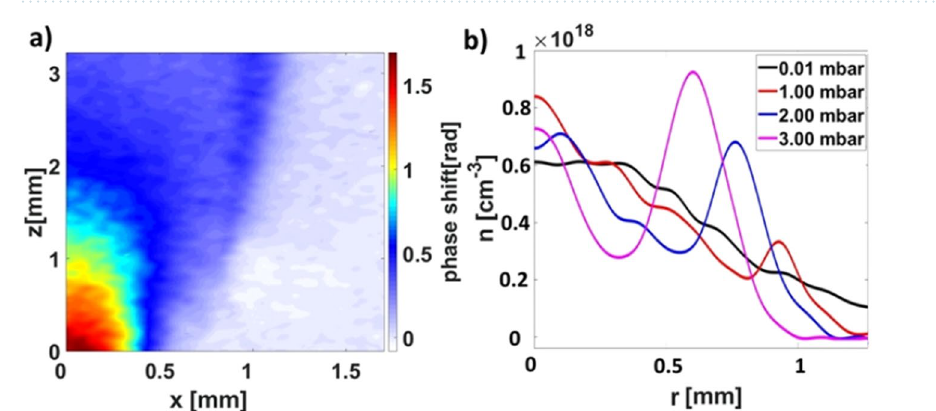
Figure 5. ( a ) Phase map of Ar with backing pressure of 1.6 bar and ambient pressure of 1.0 mbar showing the clear barrel shock formed on the edge of the jet. ( b ) Gas density distribution of Ar gas jets (backing pressure 1.6 bar) during expansion in ambient gas pressure in the range of 0–3 mbar at the height of 2 mm above the nozzle